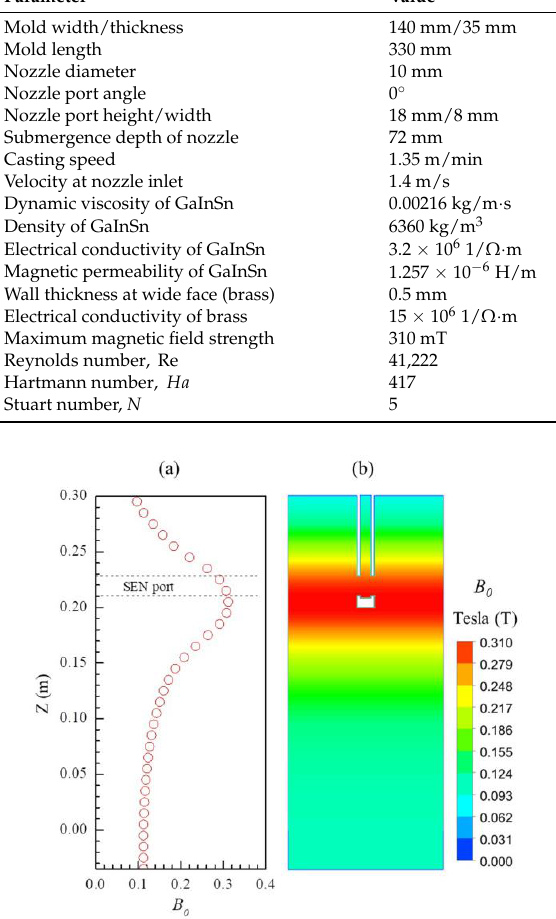
Figure 1. Applied magnetic field profile in vertical direction [14]: ( a ) profile; ( b ) contour plot.